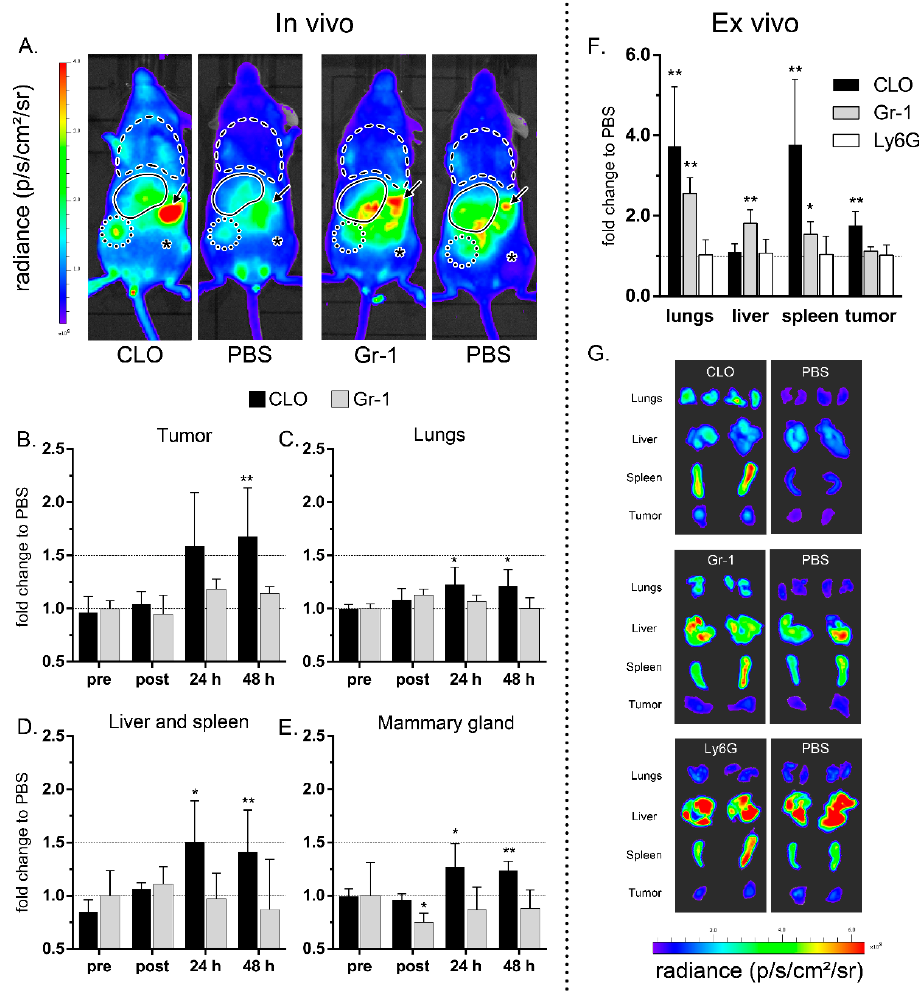
Figure 1. Depletion of the mononuclear phagocyte system increases the accumulation of exogenously injected bone marrow-derived monocytes (BMDMs) in the tumor and in other tissues. Mice were pre- treated with PBS, clodronate liposomes (CLO), anti-Gr-1 (Gr-1) or anti-Ly6G (Ly6G) antibodies 24 hours before administration of 10 6 DiD-labeled BMDMs. The total radiant efficiency was measured using macroscopic in vivo fluorescence imaging right before (pre) and directly after (post) BMDM injection as well as at 24 hours and 48 hours after injection. In ( A ), representative in vivo fluorescence images 48 h after BMDM injection are shown. The symbols represent the lungs (dashed line), the tumor (dotted circle), opposite mammary gland (asterisk), spleen (arrow) and presumed location of the liver (full line). ( B – E ) The fold change in BMDM accumulation immediately before (pre) and after (post) as well as at 24 and 48 hours after injection of DiD-labelled BMDMs were calculated relative to control mice that were pretreated with PBS (y = 1). ( F ) Directly after the last in vivo measurement, the fluorescence of each individual organ was measured ex vivo and compared to the PBS pretreated control mice (y = 1). ( G ) Representative ex vivo fluorescence images of the tumors and dissected organs. The depletion experiments were independently conducted. This explains the variation in fluorescence between the PBS groups in G and in Figure S1D-F. The error bars represent the standard deviations ( n = 6). * p < 0.05, ** p < 0.01 compared to the respective PBS control at each separate time point. Individual measurements can be found in Supplementary Figure S2.